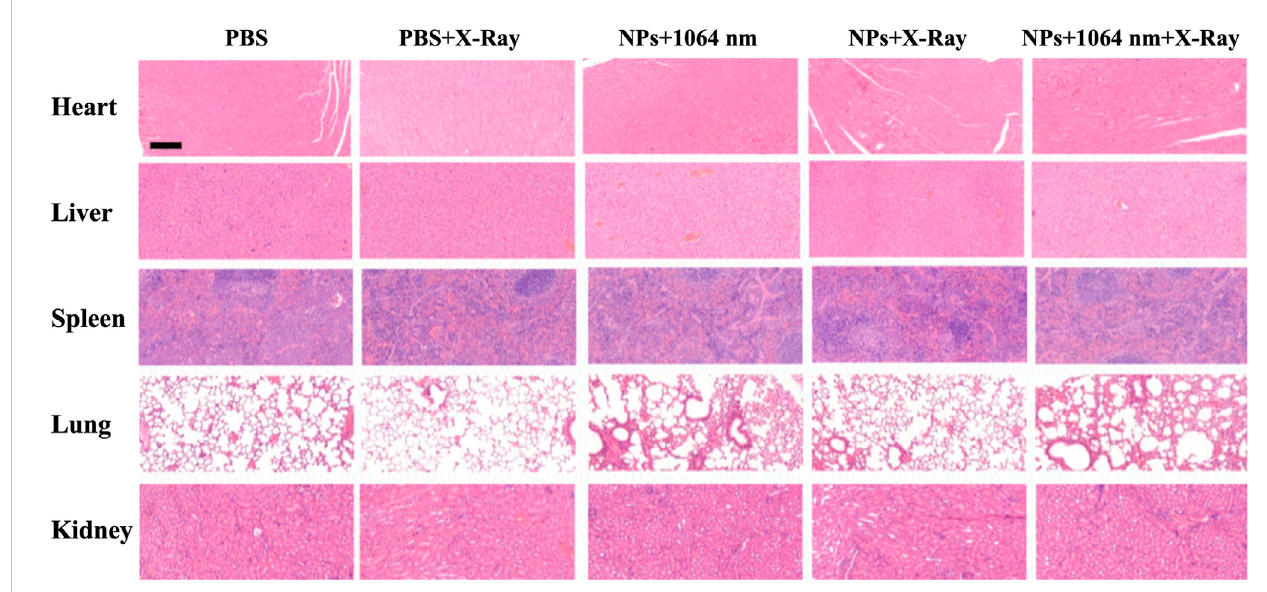
FIGURE 5 H&E staining of different organs of 4T1-tumor-bearing BLAB/c nude mice after 14 days. The scale bar is 50 μ